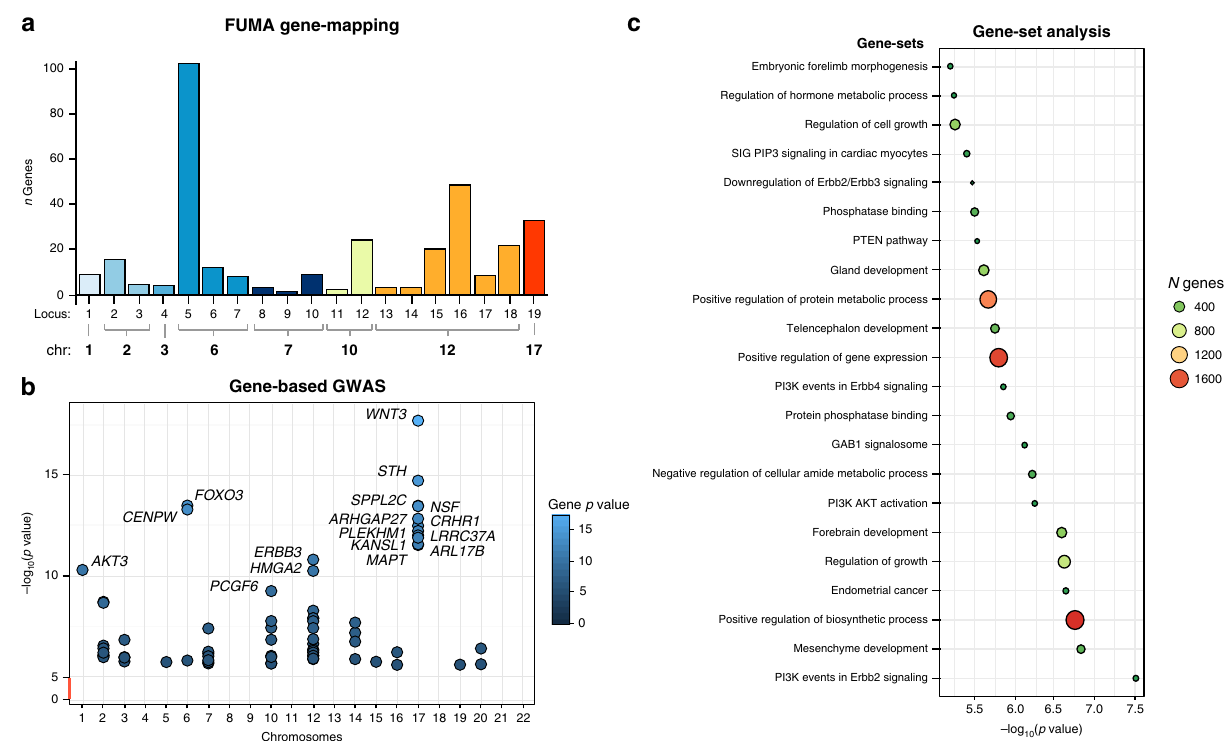
Fig. 2 Gene analyses based on the GWAS meta-analysis of BV. a Number of genes that were mapped by FUMA to each locus. Colors indicate distinct chromosome numbers. b Signi fi cant genes in the gene-based association test in MAGMA after Bonferroni correction ( P < 0.05/18,169). The x -axis represents the chromosome number, y -axis and the dot color shows the negative log 10 -transformed gene-based P- value. The top 15 most signi fi cant genes are annotated with the corresponding gene symbols. c Signi fi cant MsigDB gene sets after Bonferroni correction ( P < 3.90 × 10 − 6 ( = 0.05/(12,191 + 53 + 565)) showing the negative log 10 -transformed P- value on the x -axis; size and colors of the circles represent the size of the gene